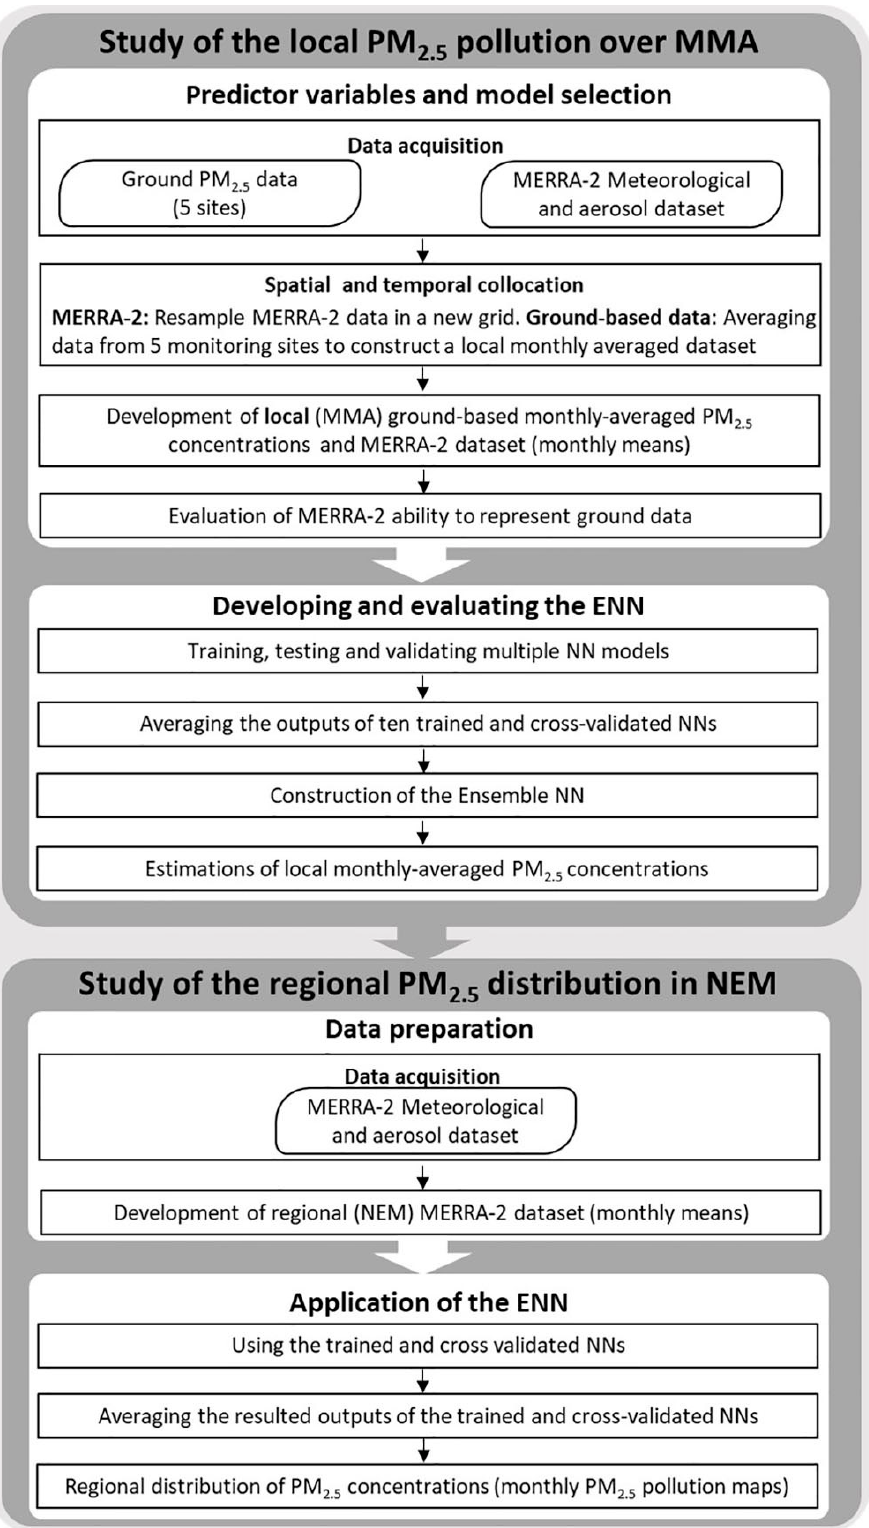
Figure 1. Methodological framework for analyzing the spatial-temporal distribution of PM 2.5.